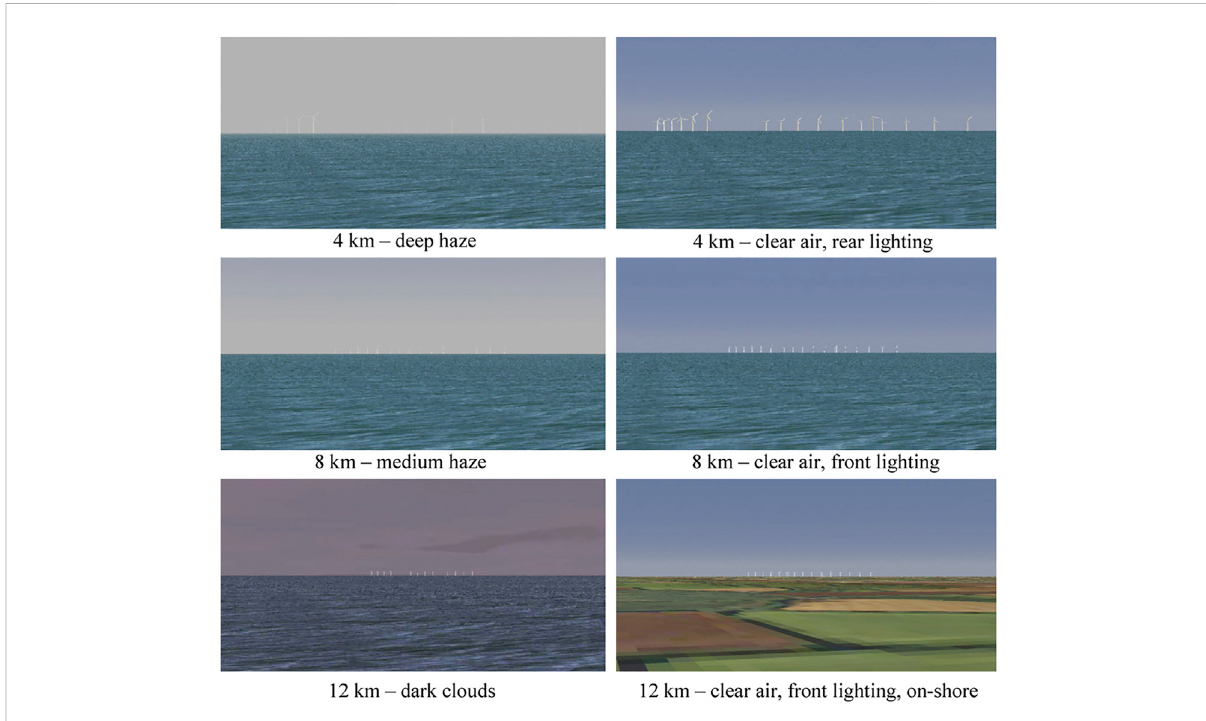
FIGURE 1 Simulation of visibility as a variable of distance: the visual recognition of turbines appears weak at around 8 km and compromised at around 12. Source of image: Bishop and Miller (2007, page